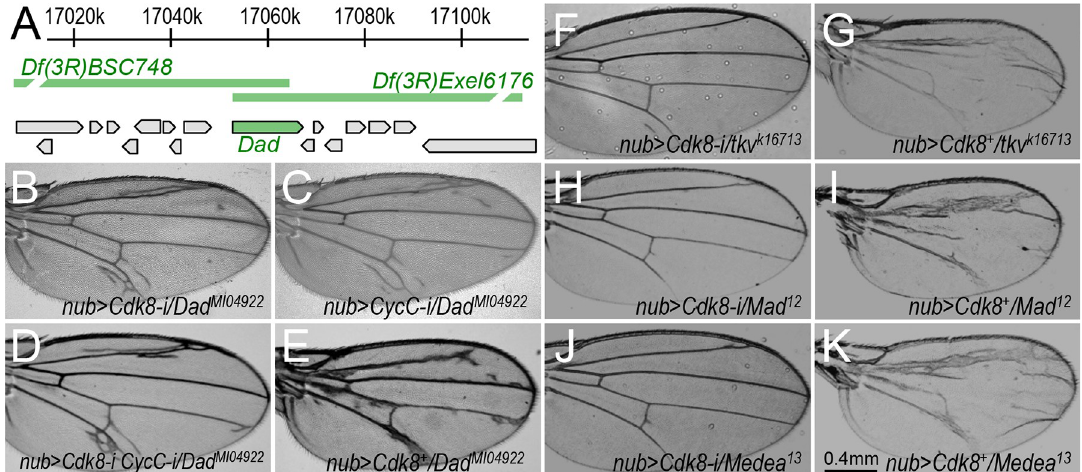
Fig 4. Identification of the Dad gene and genes encoding other components of the Dpp signaling pathway as dominant modifiers of the CDK8-specific phenotypes. (A) Schematic diagram of the genome region of Df(3R)BSC748 and Df(3R)Exel6176 , which uncover the gene dad . Adult wings with the following genotypes: (B) nub-Gal4/+; UAS-Cdk8-RNAi/Dad MI04922 ; (C) nub-Gal4/+;